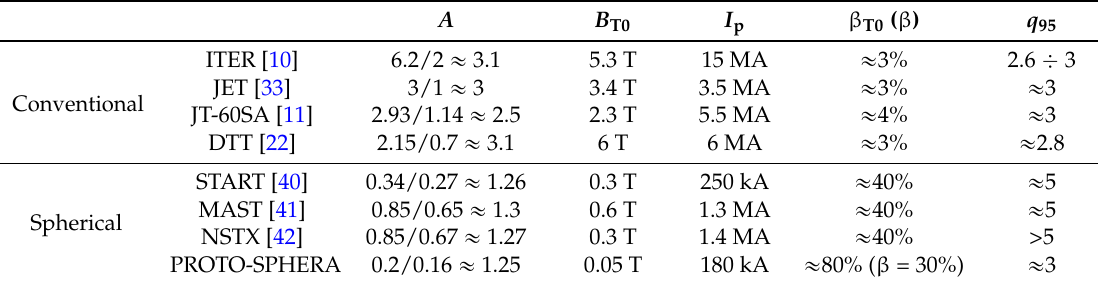
Table 1. Typical (approximate) parameters of relevant fusion devices. A B T0 I p β T0 ( β ) q